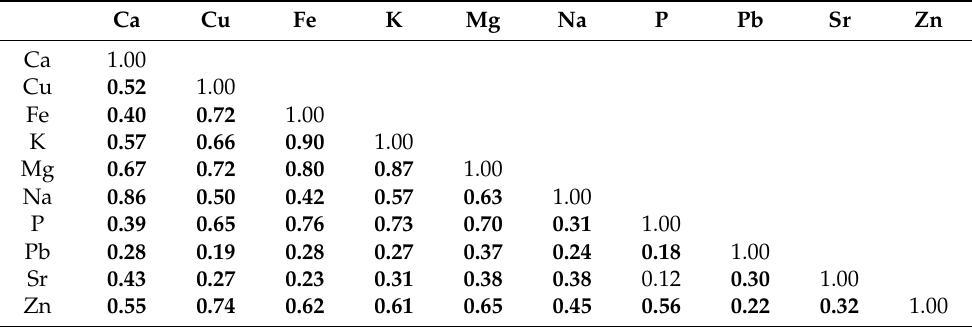
Table 5. Spearman’s rank correlation cofactors between elements in the cord blood.